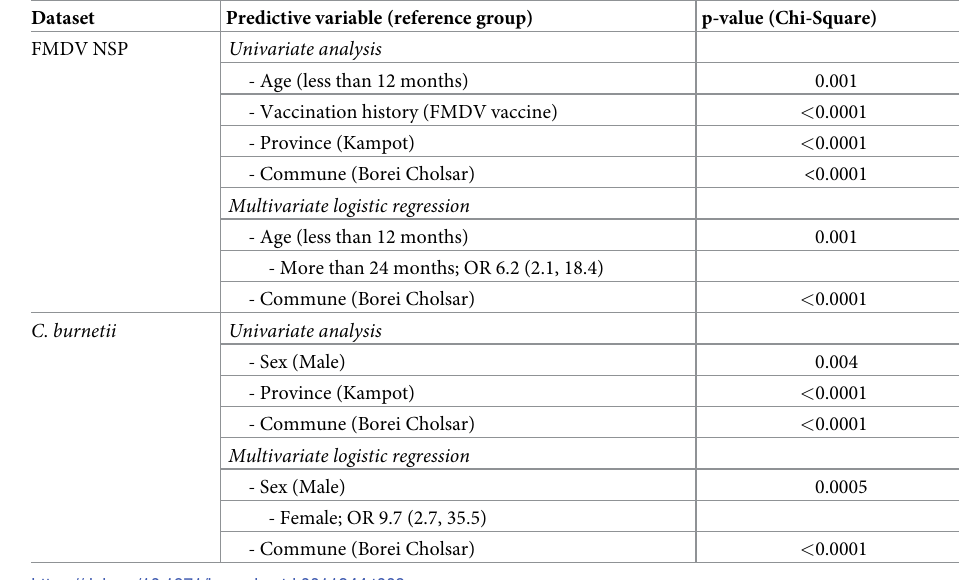
Fig 4. True FMDV NSP and Q Fever seroprevalence at the provincial level. Map shapefiles sourced from https://www.diva-gis.org/gdata. https://doi.org/10.1371/journal.pntd.0011244.g004 Table 3. Statistical modelling of FMDV and C.